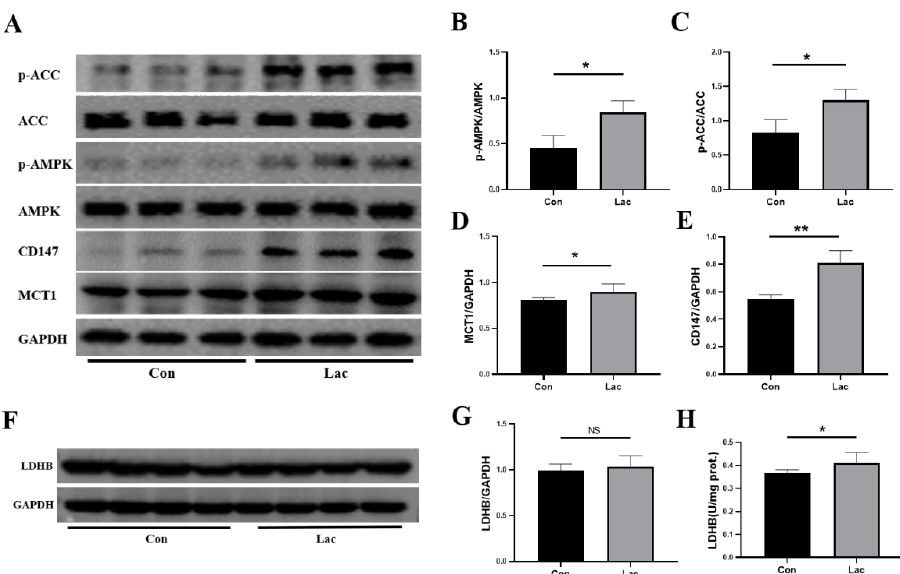
Figure 8. Lactate upregulated energy metabolism in myoblasts. Cells were treated for 2 h in either DMEM medium (Con) or DMEM medium supplemented with 5 mM lactate (Lac). ( A ) Expressions of p-AMPK (Thr172), p-ACC (Ser79), CD147 and MCT1 LDHB analyzed by Western blot ( n = 3); ( B – E ) Gray value analyses corresponding to Panel ( A ); ( F ) LDHB analyzed by Western blot ( n = 4); ( G ) Gray value analyses corresponding to Panel ( F ); and ( H ) Enzymatic activity of LDHB ( n = 5). Results are presented as Mean ± SD. * p < 0.05, ** p < 0.01, NS: Not Statistically, for the statistical analysis of Lac vs.